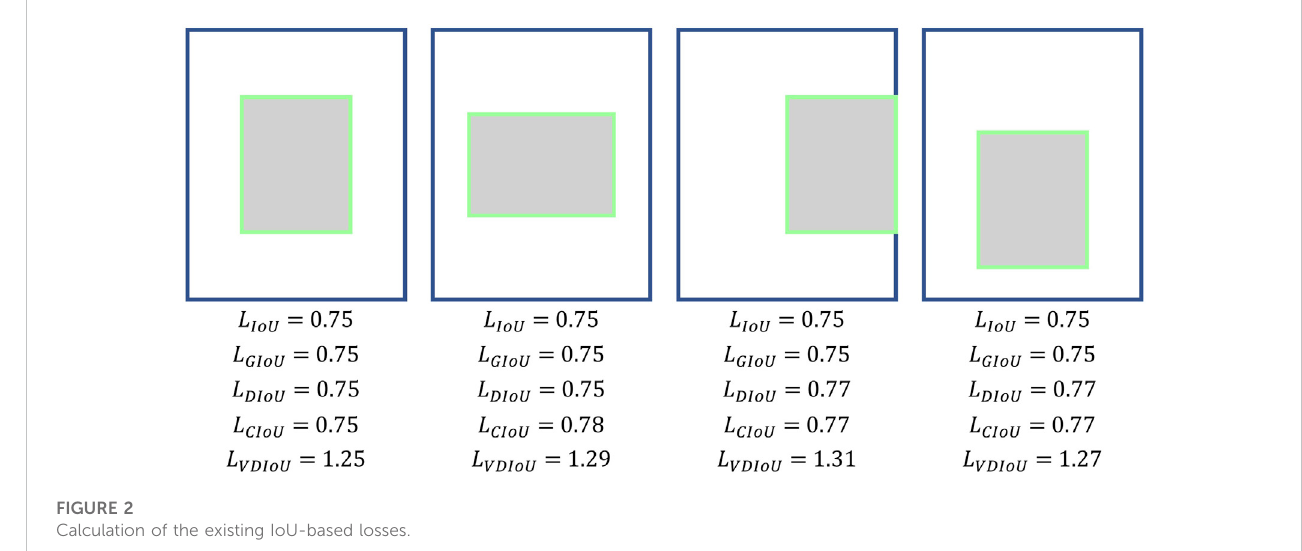
FIGURE 2 Calculation of the existing IoU-based losses.